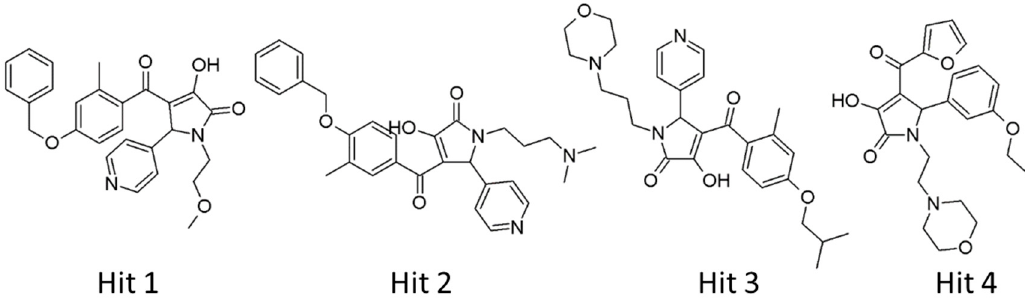
Figure 10. 2D structures of final hit compounds.